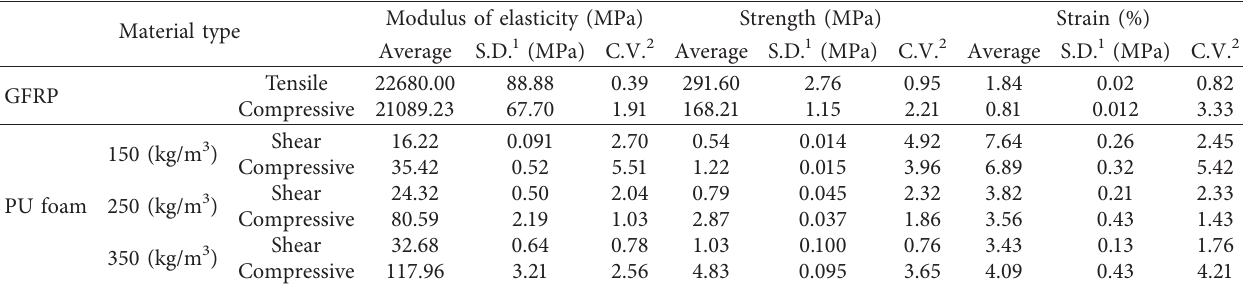
Table 1: Summary of mechanical properties of GFRP laminates and the PU foam core.